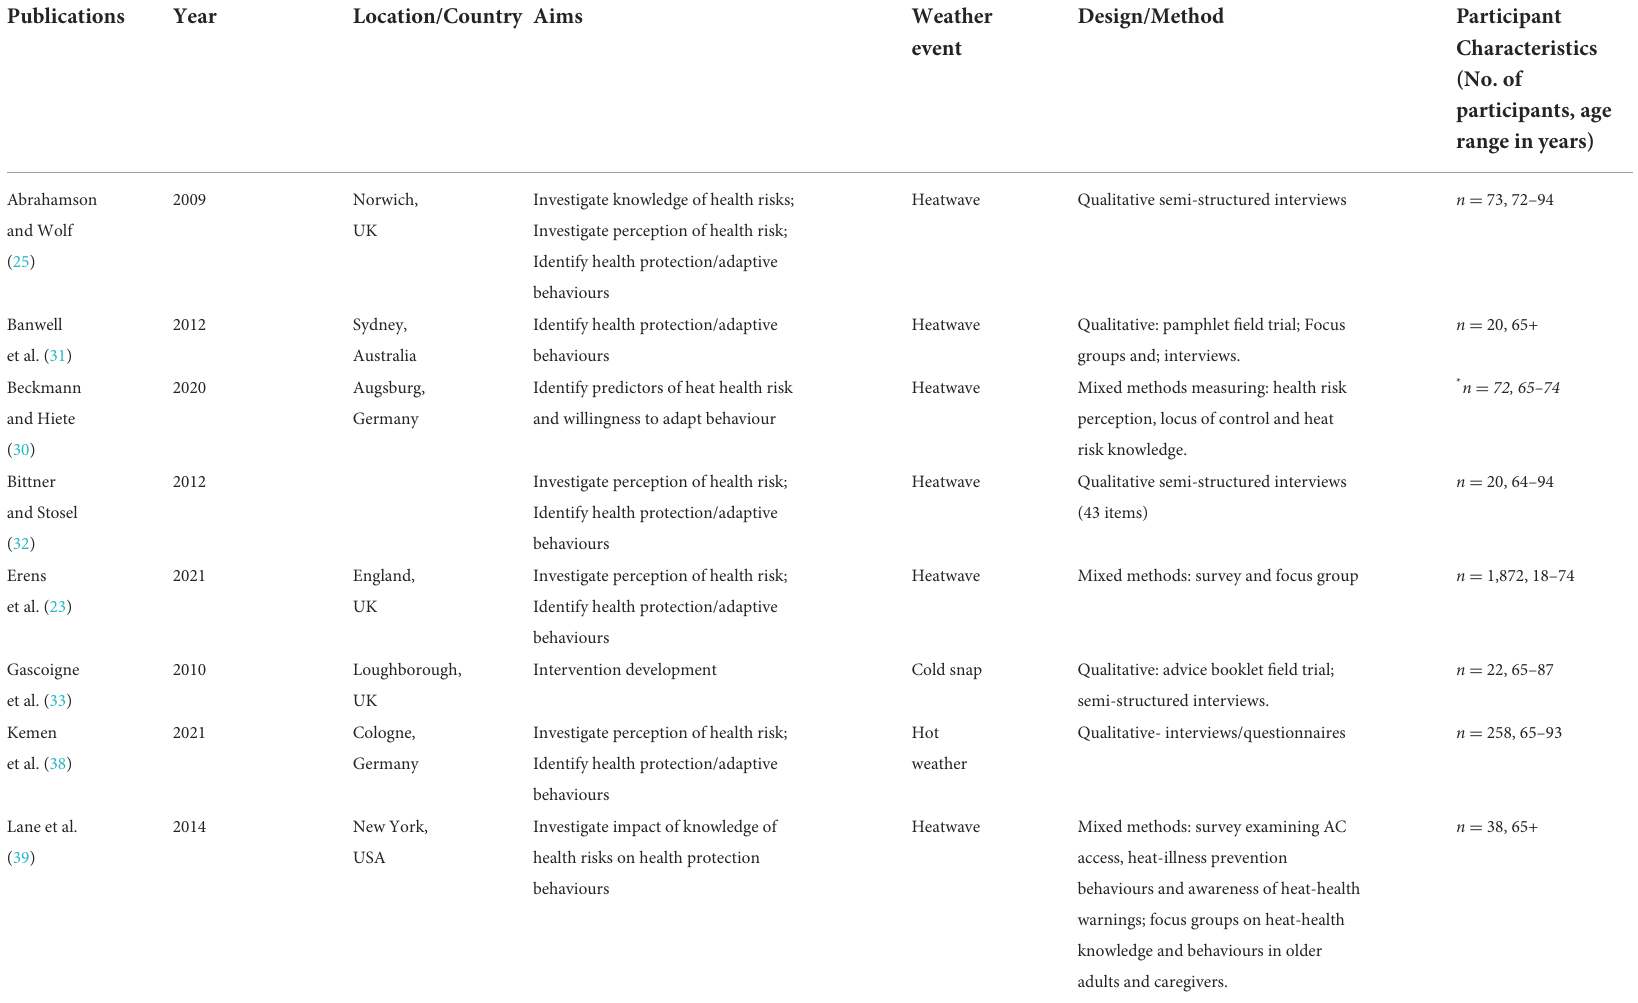
TABLE 2 Summary of the characteristics of the included papers including publication year, country of publication, study aims, weather hazard, study design/methods and participant sample characteristics.